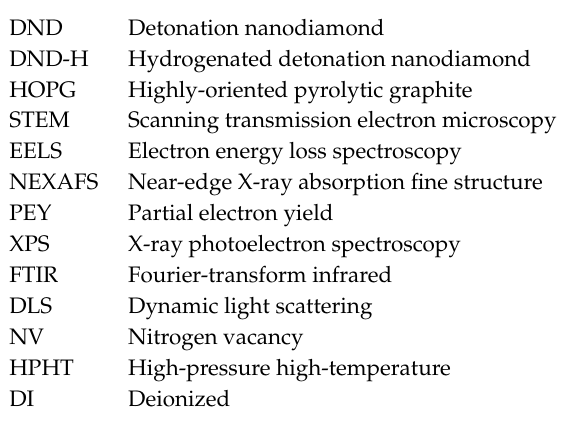
Figure S1: Electron-energy loss spectra of the C1s K-edge for DND-H Anneal and DND-H Plasma samples; Figure S2: Carbon K-edge NEXAFS spectra with shaded sp 2 and sp 3 ranges used for determining the sp 2 /sp 3 rati0; Figure S3: Full XPS spectra of the starting oxidized DND and both hydrogenated DND samples. Spectra not corrected for charging effects; Figure S4: Full range of FTIR data for the starting DND Oxidized material and the two hydrogenated DND samples; Figure S5: Colloidal properties of hydrogenated DND particles dispersed in water at ~0.4 mg mL − 1 . (A) The averaged intensity-weighted size distribution of the DND aggregates, and (B) their corresponding averaged z-potential; Figure S6: Raw dynamic light scattering results for both (A–C) DND-H Anneal and (D–F) DND-H Plasma samples with (A & D) intensity; (B & E) number; and (C & F) volume weighted distributions; Figure S7: Raw z-potential for (A) DND-H Anneal and (B) DND-H Plasma samples; Figure S8: Schematic of our custom-built in-solution spectroscopy setup used for all in-solution experiments with all components labelled; Figure S9: In-solution spectra of (A) DND-H Anneal and (B) DND-H Plasma samples at different excitation wavelengths; normalized for differences in excitation power. (C) Change in peak emission wavelength as a function of excitation wavelength. Raw (D) DND-H Anneal and (E) DND-H Plasma results not corrected for differences in excitation power or (F) water signal; Figure S10: Room-temperature solid state PL maps of (A) DND-H Anneal and (B) DND-H Plasma samples drop-cast onto Si wafers. Excited using a 532 ± 30 nm pulsed excitation source at 5 MHz repetition rate at 50 µW; Figure S11: Room-temperature solid state fluorescence spectra of (A) DND-H Anneal and (B) DND-H Plasma samples corresponding to PL maps in Figure S10; Figure S12: Averaged fluorescence spectra of (A) DND-H Anneal and (B) DND-H Plasma samples for temperatures ranging from 293 K in air atmosphere and vacuum to 10 K. Faded envelopes around solid lines indicate standard deviation between measurements; Figure S13: Peak emission wavelength of hydrogenated DND samples on Si substrates as a function of changing temperature. Postscripts ‘a’ and ‘v’ refer to ambient atmospheric pressure and in-vacuum respectively. All measurements at temperatures <293 K were performed in vacuum; Table S1: Combination of excitation wavelength, power, and filters used for in-solution fluorescence spectroscopy measurements. Total acquisition time for each spectrum was 100 s. Excitation laser source was set to 80 MHz repetition rate for all excitation